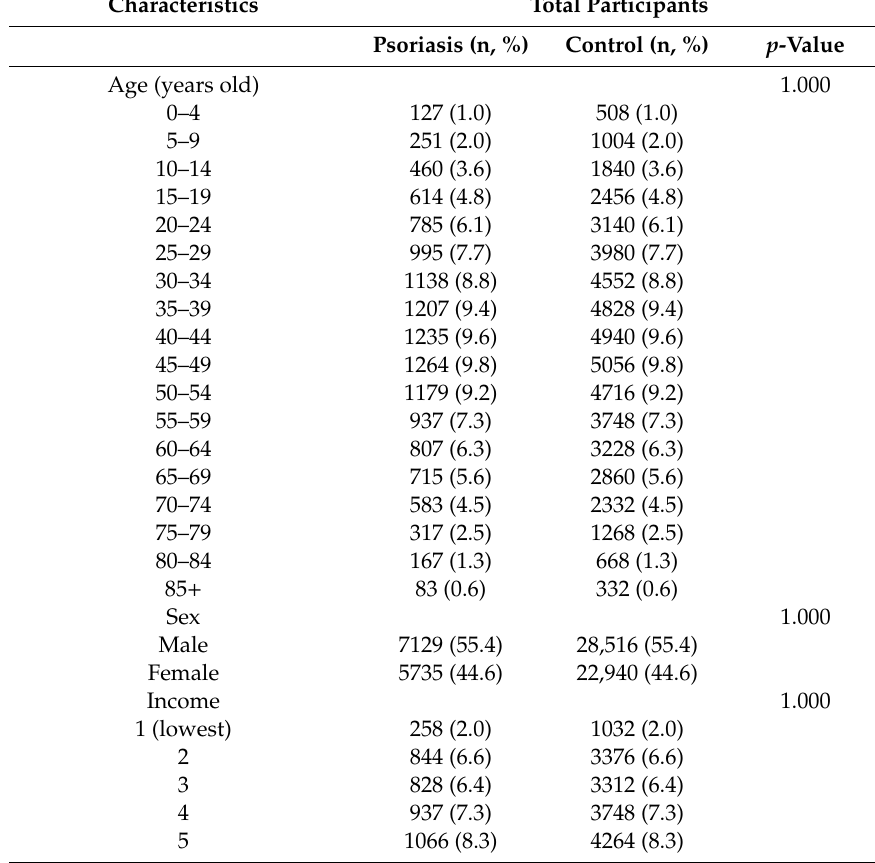
Table 1. General characteristics of